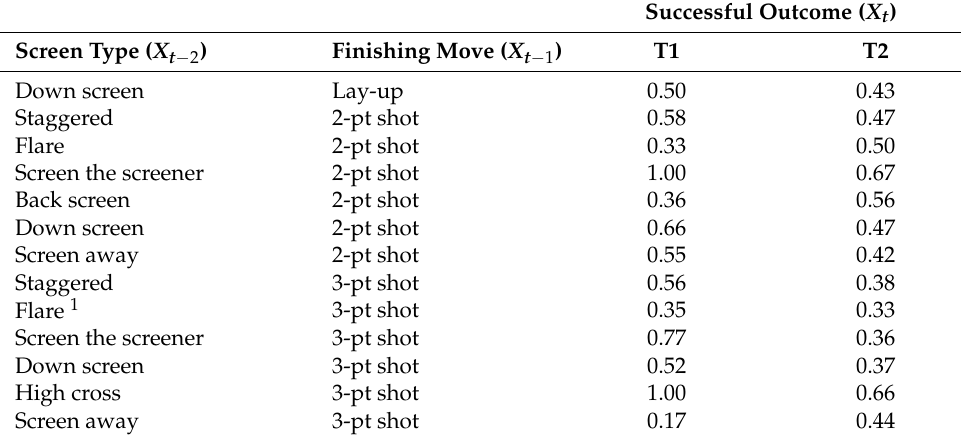
Table 6. Transition probabilities between finishing moves and screens to successful shots. Successful Outcome ( X t